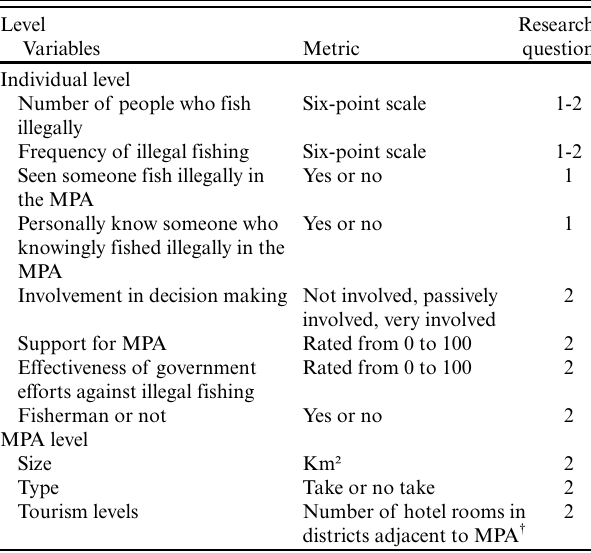
Table 2 . Individual and marine protected area (MPA) variables used to explain compliance, with corresponding research question (s) for each